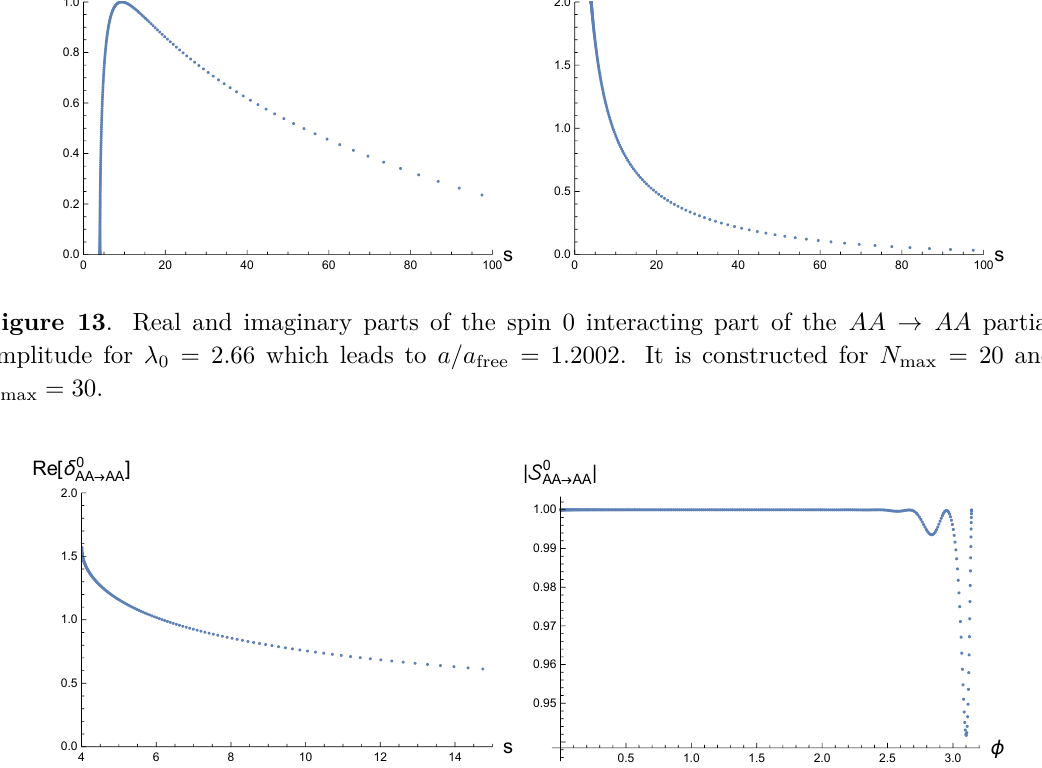
Figure 14 . Left plot represents the real part of the spin 0 phase shift of the AA → AA scattering defined in (5.17). No resonances are present. Right plot represents the absolute value of the spin 0 partial amplitude of the AA → AA scattering. On the real axis instead of s variable we use φ variable defined in (G.25). The amplitude is fully “elastic” up to very high energies.